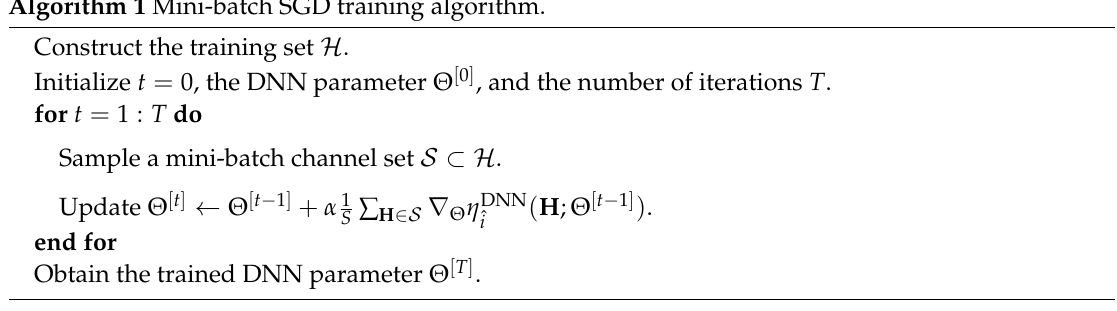
Algorithm 1 Mini-batch SGD training